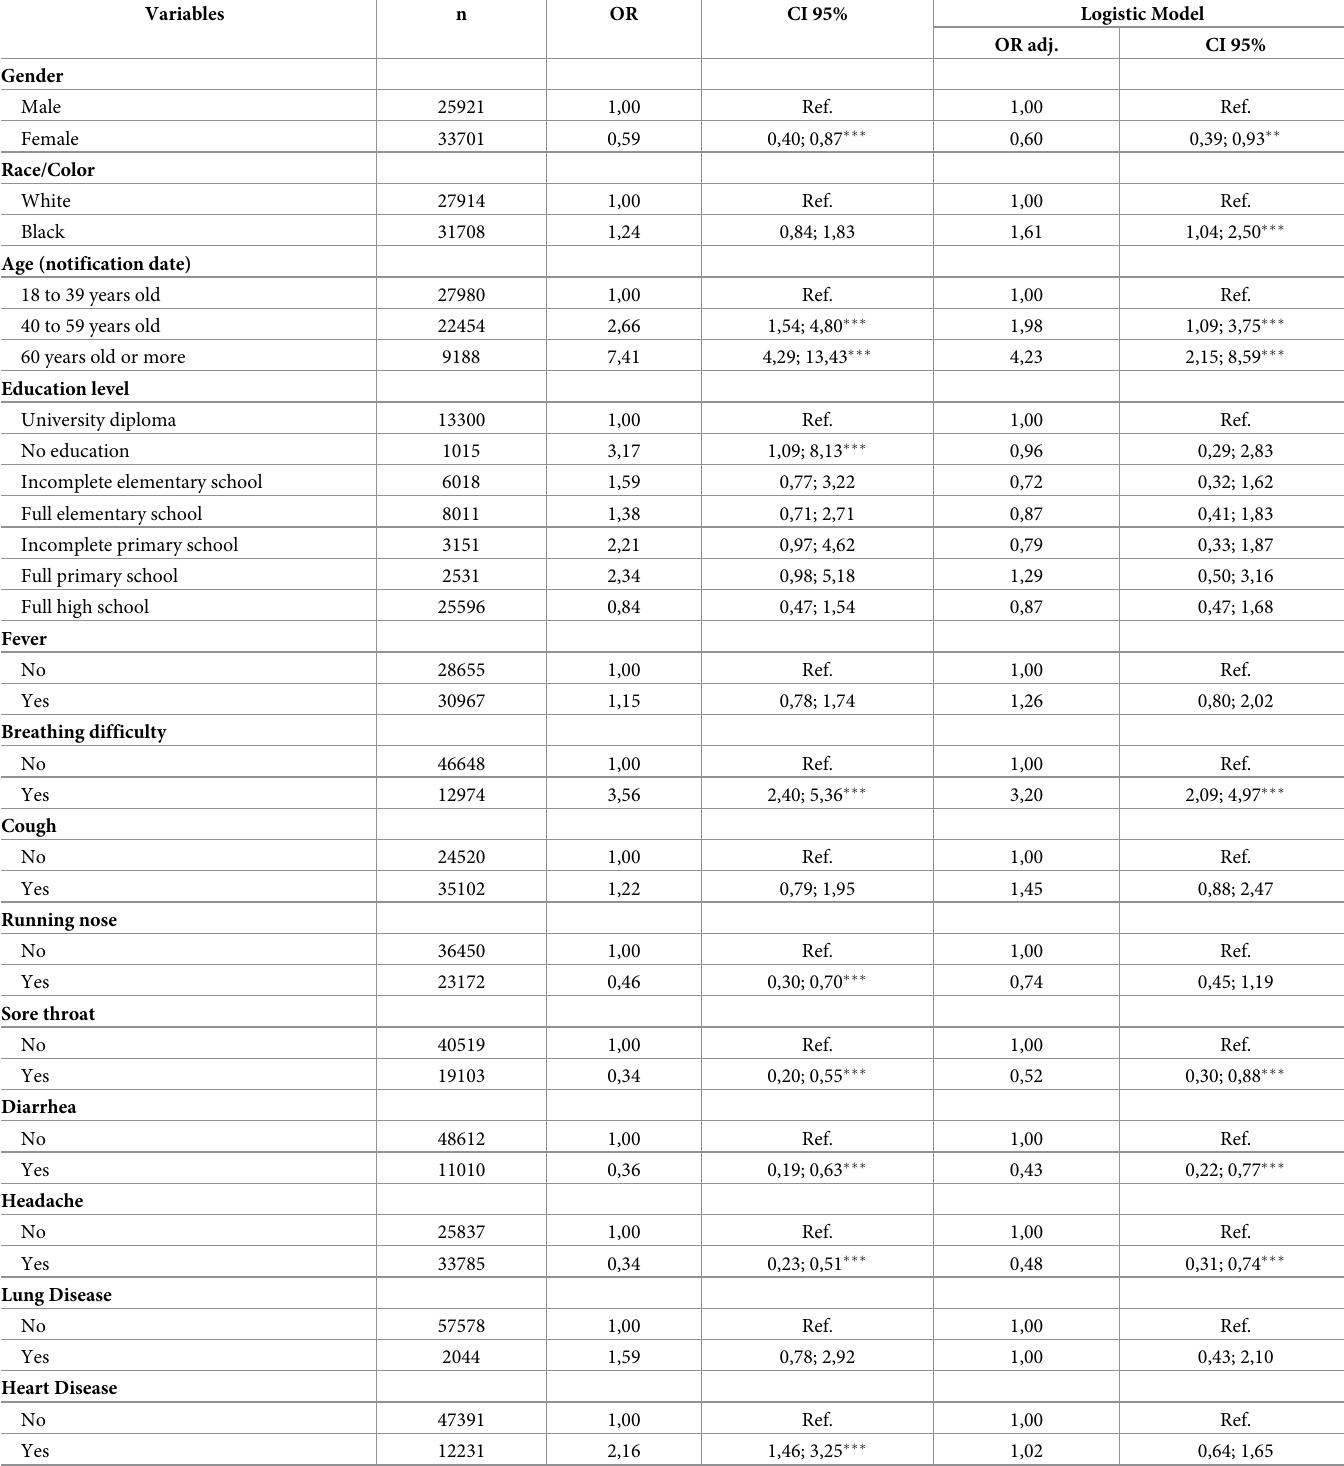
Table 4. Logistic regression model for the association of sociodemographic factors and symptoms with hospitalization by COVID-19 in patients with obesity, Espı´- rito Santo, Brazil,